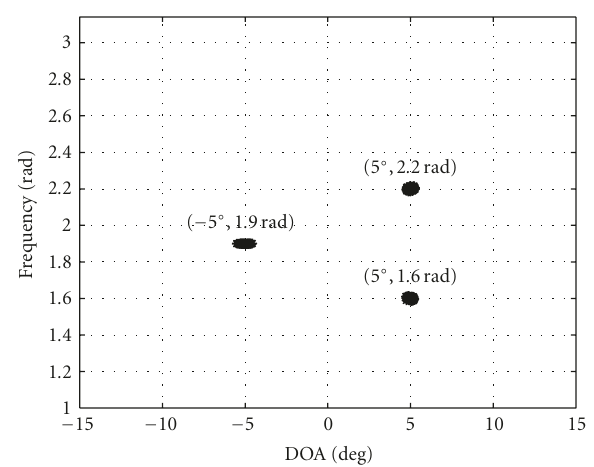
Figure 5: Scatter plot of estimated DOA/frequency pairs with proposed method. SNRs = 10 dB, M = 6, K = 2, N = 100, and 1000 trials are